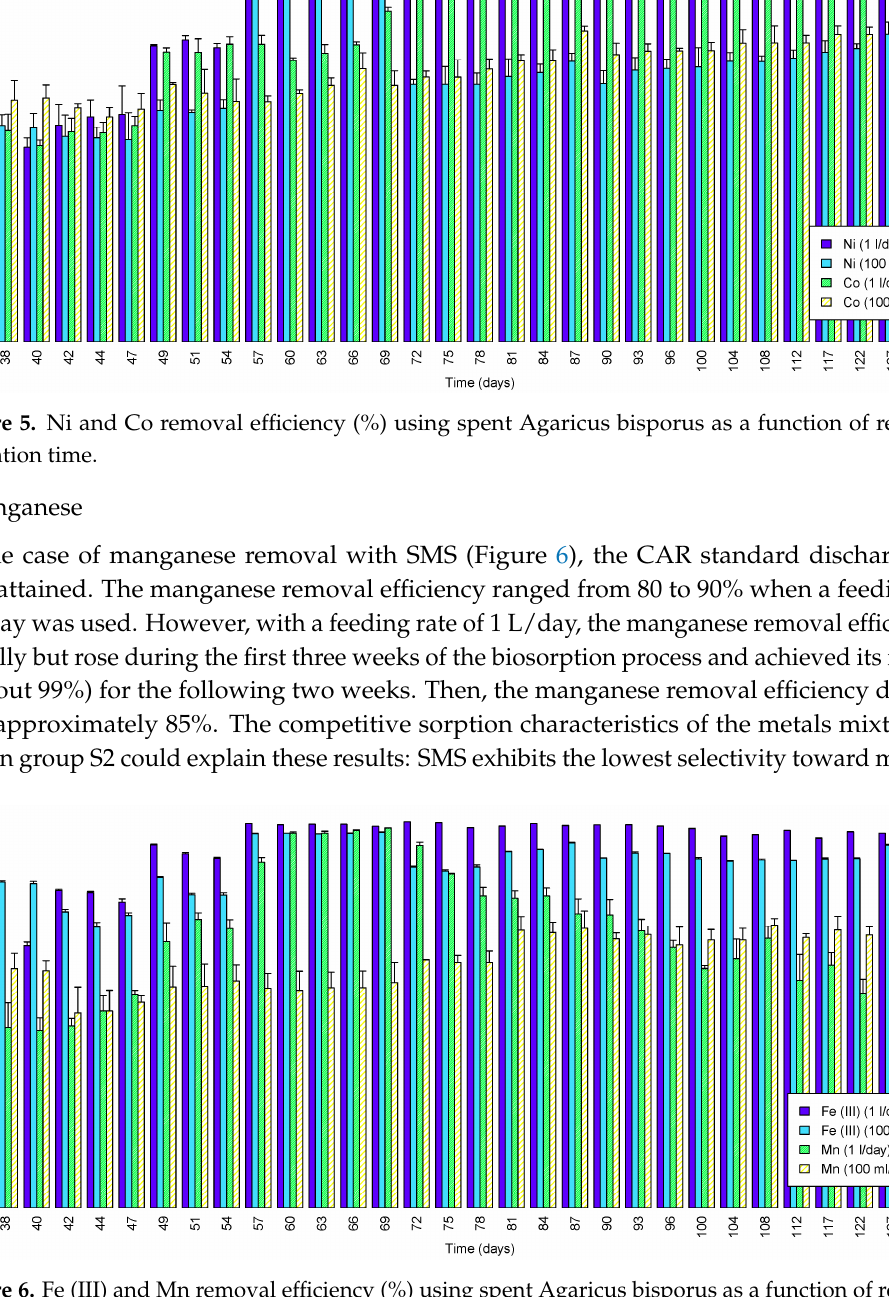
Figure 6. Fe (III) and Mn removal efficiency (%) using spent Agaricus bisporus as a function of reactor operation time.